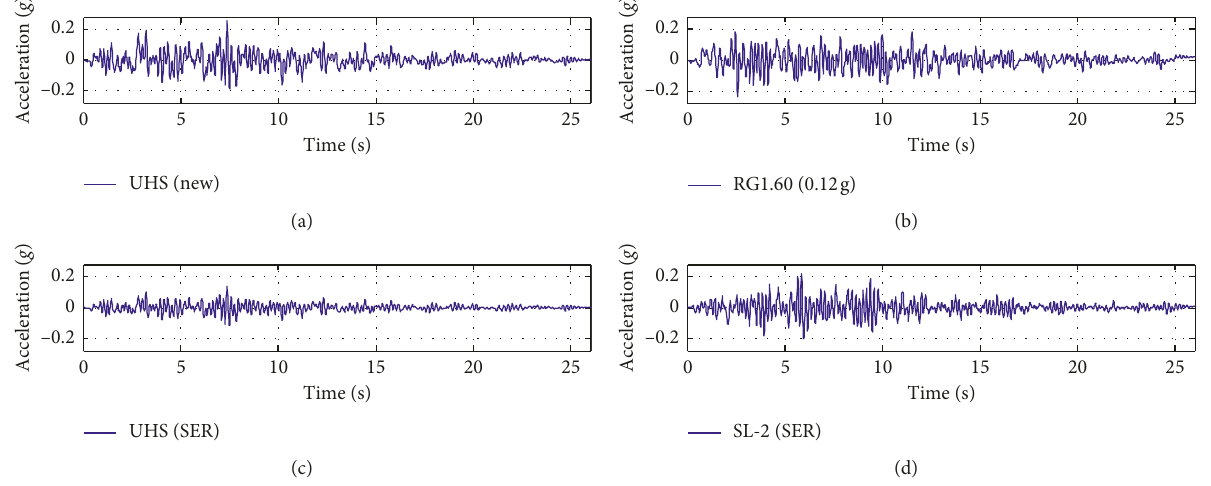
Figure 17: Acceleration time-history curve at